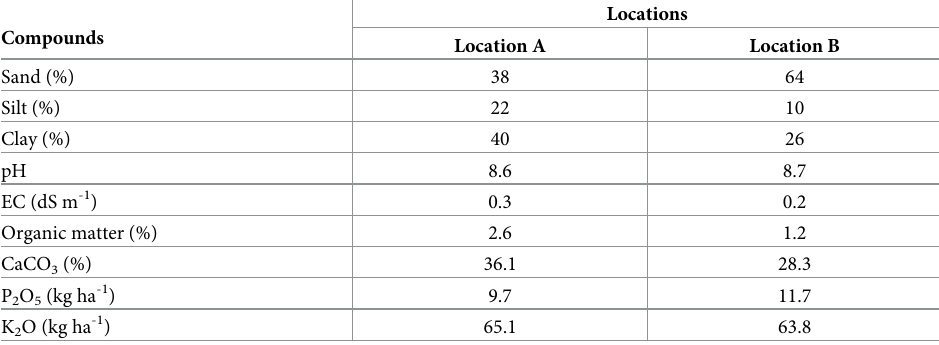
Table 1. Physical and chemical properties of the soils in the experimental areas (locations) (0–20